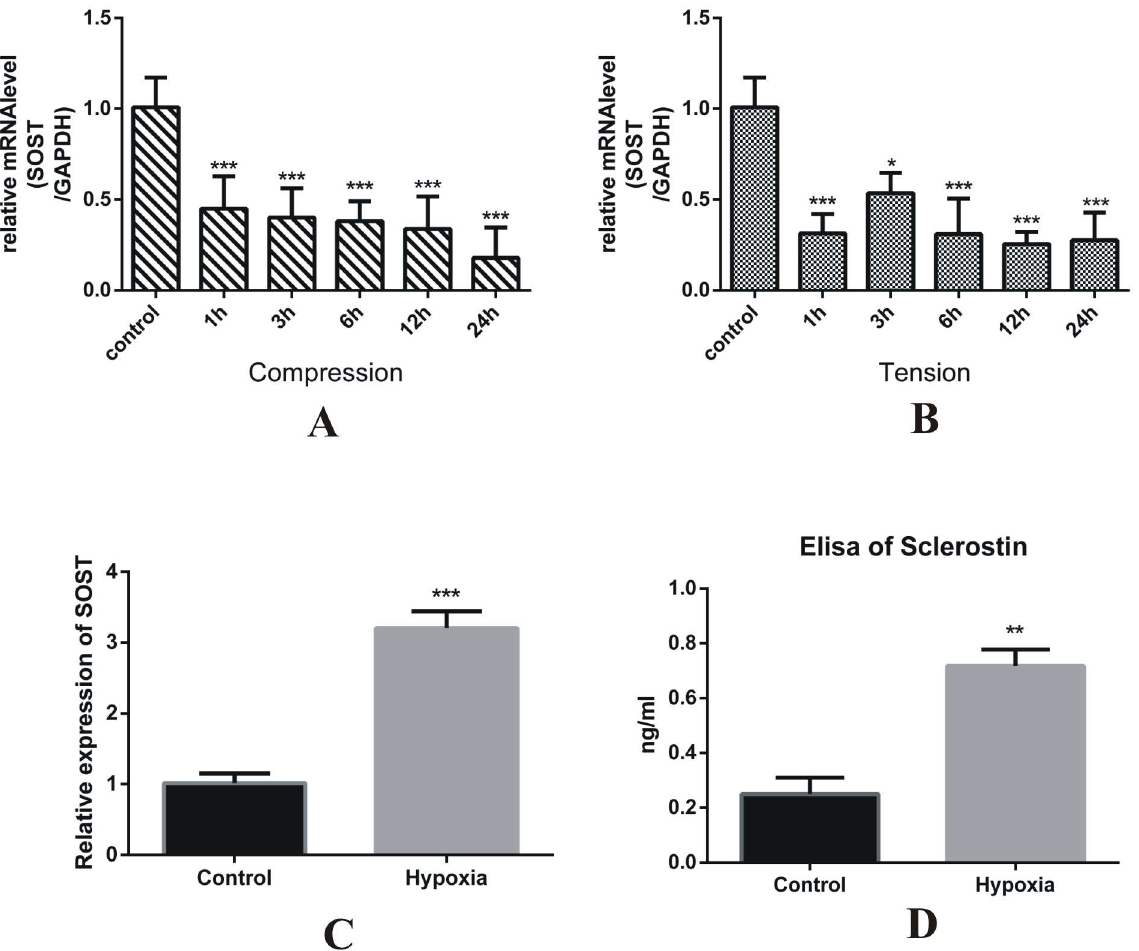
Fig 2. The sclerostin expression of the MLO-Y4 cells was increased under hypoxic conditions, whereas it was not different under uniaxial compression and tension stress. (A) The relative mRNA expressionof SOST of the MLO-Y4 cells was decreased under compression stress. *** p < 0.001vs control. (B) The relative mRNA expressionof SOST of the MLO-Y4 cells was decreased under compression stress. *** p < 0.001vs control. (C) The relative mRNA expressionof the SOST mRNA of the MLO-Y4 cells was increased48 h after being culturedunder hypoxicconditions. *** p < 0.001vs control. (D) The release of sclerostinby the MLO-Y4 cells that was determined using ELISA increased48 h after being cultured under hypoxicconditions. ** p < 0.01vs